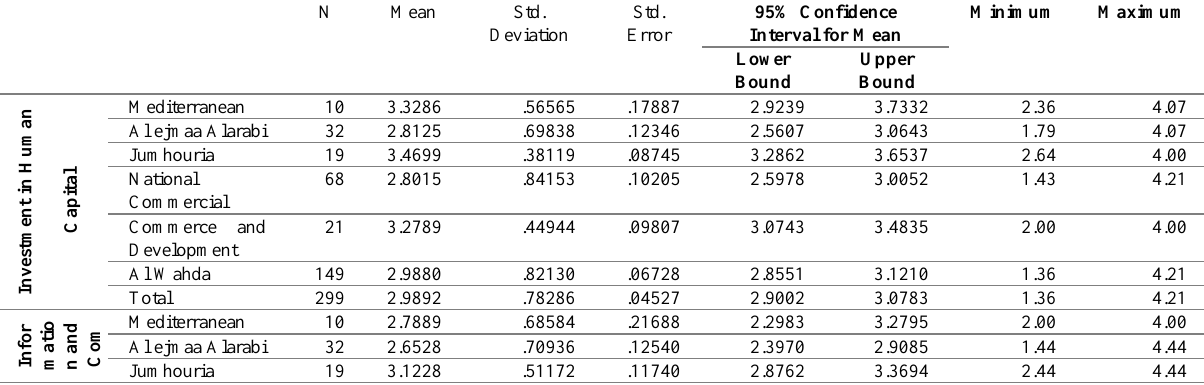
Table 9: Descriptive Statistics for Banks' Groups in The Five Study